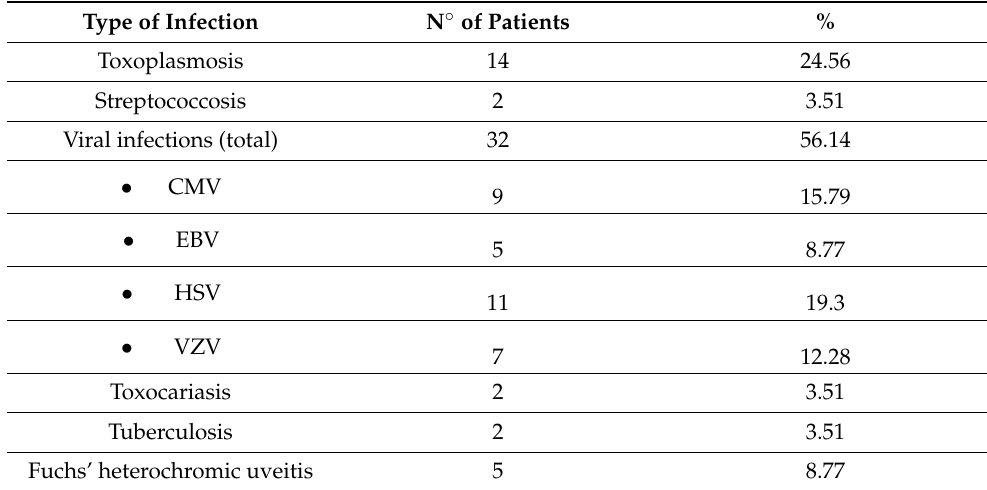
Table 2. Etiology of infectious uveitis.